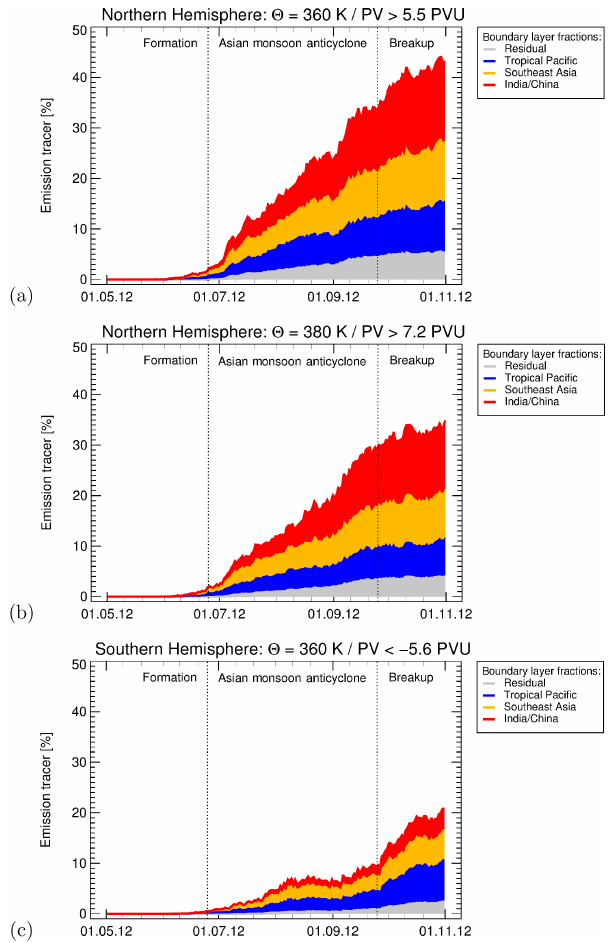
Figure 14. Contribution of different emission tracers from In- dia/China, southeast Asia, the tropical Pacific Ocean, and residual surface to the northern lower stratosphere at different levels of po- tential temperature 360K (a) and 380K (b) from May to October 2012. The same for the southern lower stratosphere at 360K (c)